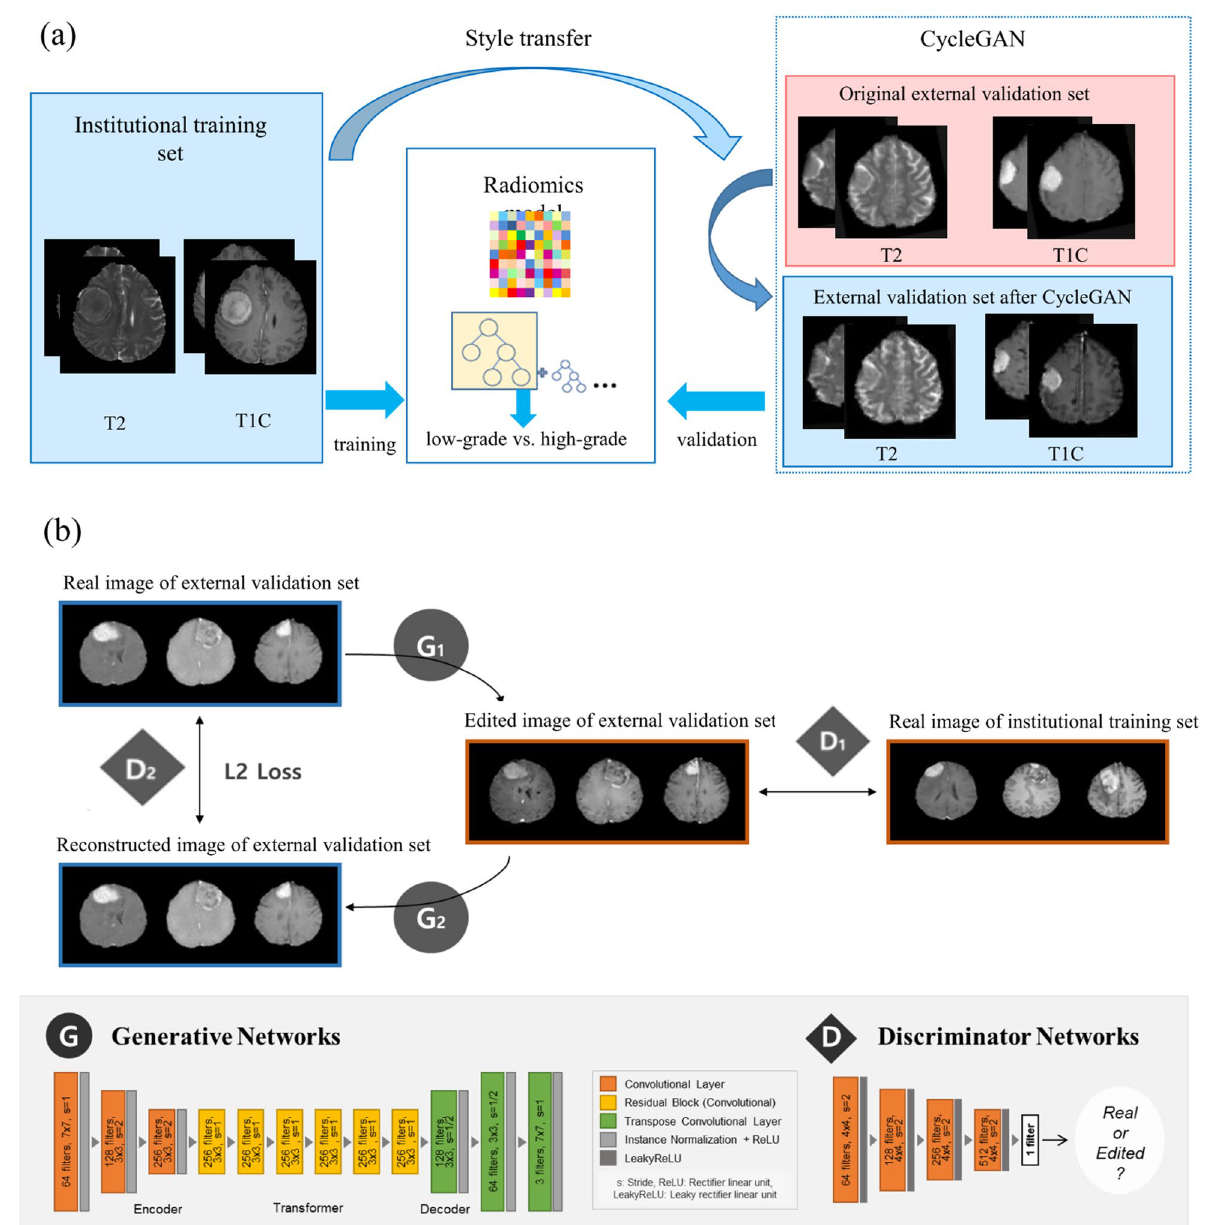
Figure 1. ( a ) Overall pipeline of the CycleGAN and radiomics for meningioma grading. ( b ) General network architecture of CycleGAN. CycleGAN = Cycle-Consistent Adversarial Networks, T1C = postcontrast T1-weighted image, T2 = T2-weighted